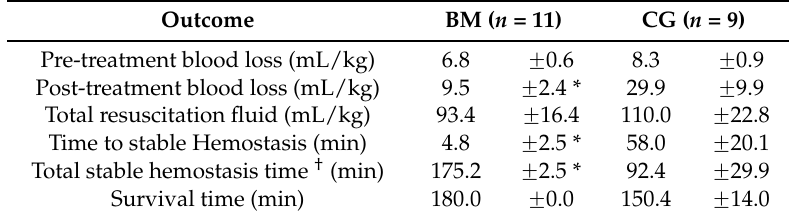
Table 2. Treatment outcomes using BM or CG following groin arterial hemorrhage.